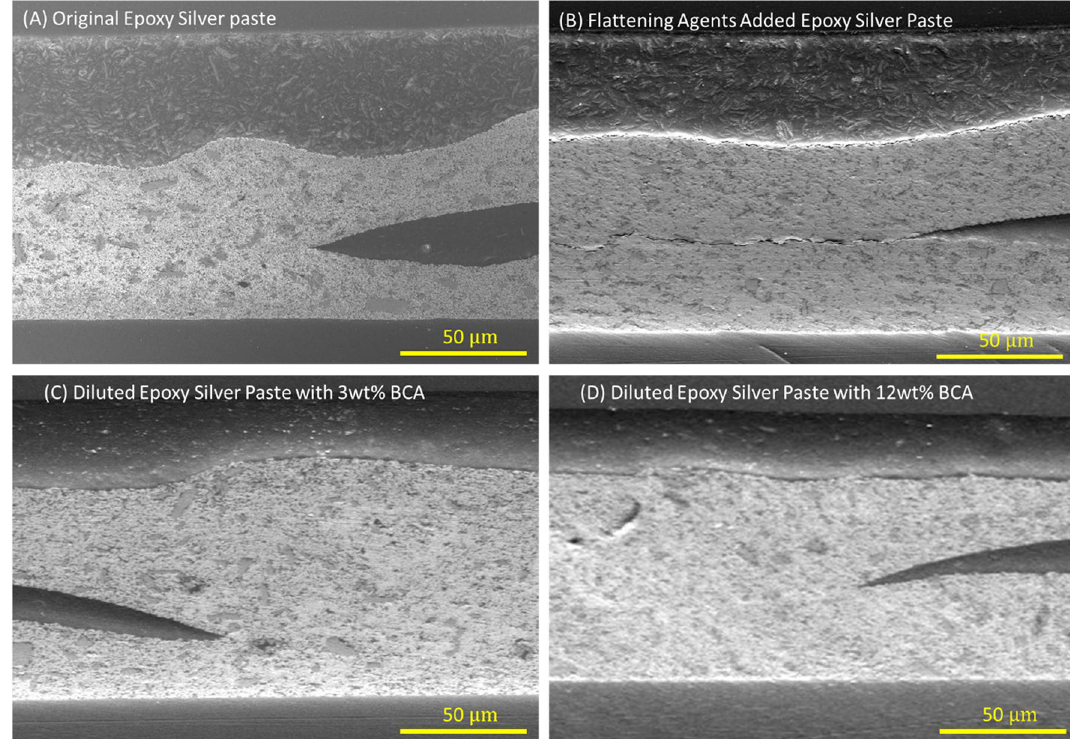
Figure 4. Coss-section between the top and bottom conductive layers at the via-holes. ( A ) Original Epoxy Silver Paste, ( B ) Epoxy Silver Paste with added flattening agent ( C ) Diluted Epoxy Silver Paste with 3wt% BCA, and ( D ) Diluted Epoxy Silver Paste with 12 wt% BCA.